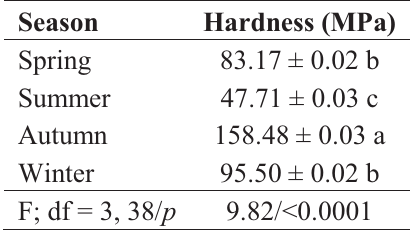
Table 1. Seasonal hardness (mean ± s.e.) (MPa) of the hemlock woolly adelgid feeding stylet insertion point across four Tsuga species. Means separation performed on log-transformed data. Means followed by the same letter do not differ ( p <